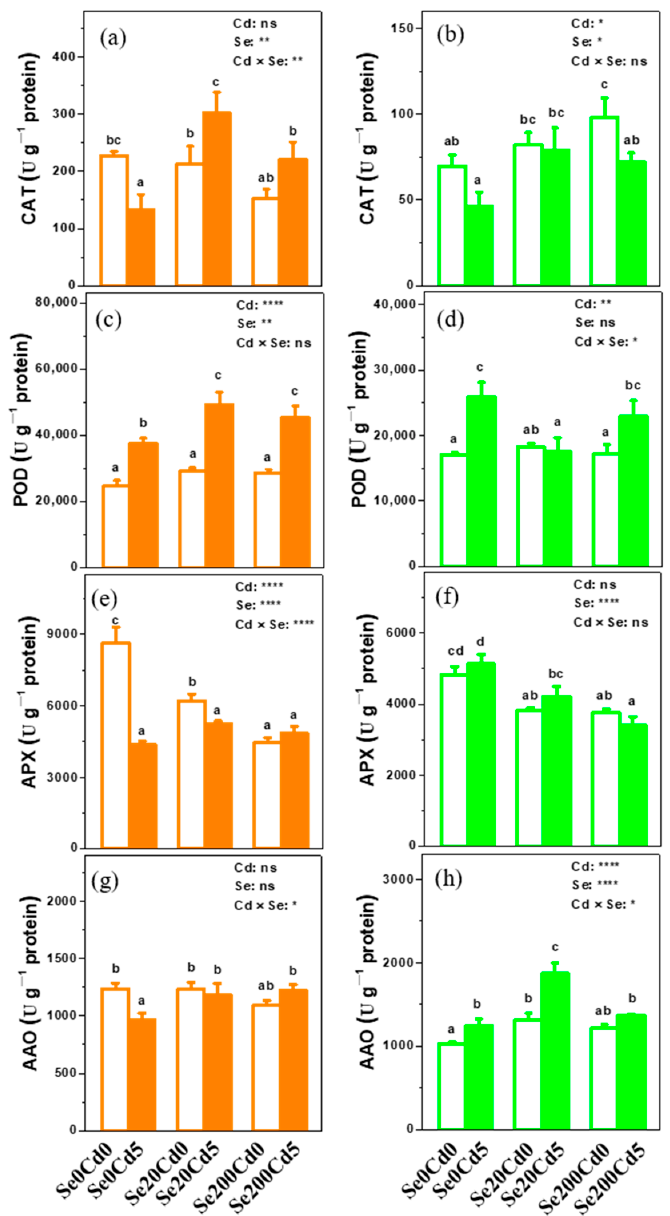
Figure 3. The activities of CAT ( a , b ), POD ( c , d ), APX ( e , f ), and AAO ( g , h ) in the roots and leaves of Xinfeng walnut exposed to either 0 (Cd0) or 5 mM (Cd5) Cd together with one of three Se levels (0 (Se0), 20 (Se20), or 200 (Se200) µ M Se). Data were means ± SE (n = 6). Different lowercase letters on the bars indicate significant difference at p < 0.05 (F-test). p -values of the ANOVAs for Cd, Se and their interaction (Cd × Se) are also indicated. *, p < 0.05; **, p < 0.01; ****, p < 0.0001; and ns, insig- nificant.